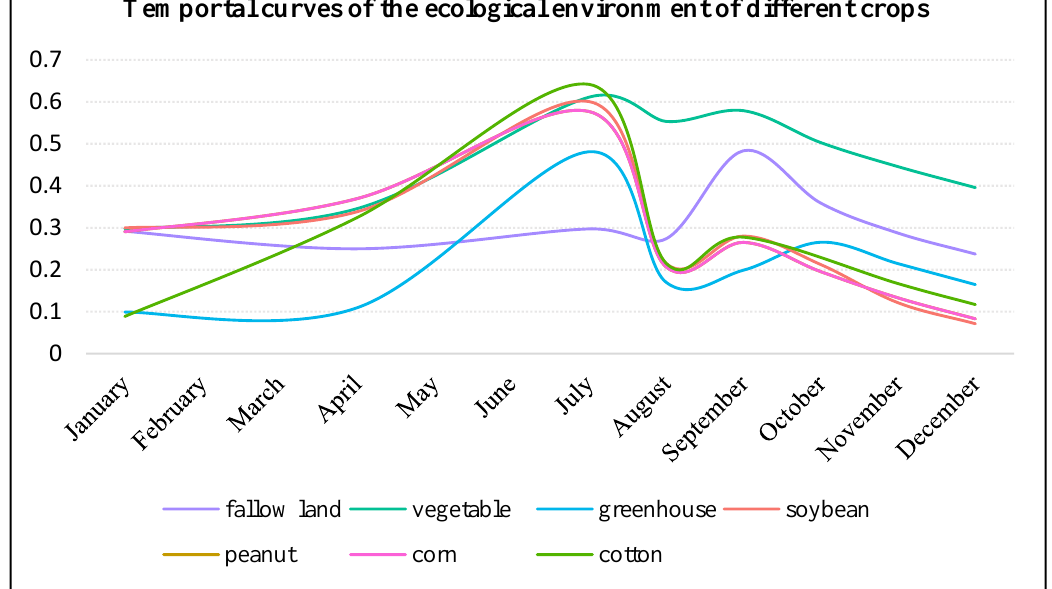
Figure 15. Time sequence diagram of ecological environmental quality change of different crop plots.